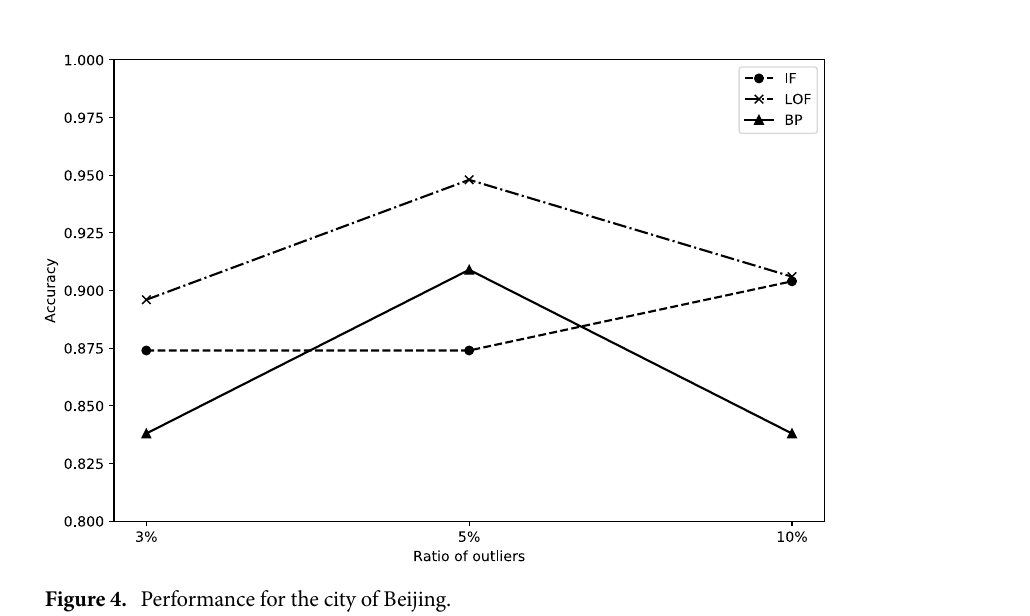
Figure 4. Performance for the city of